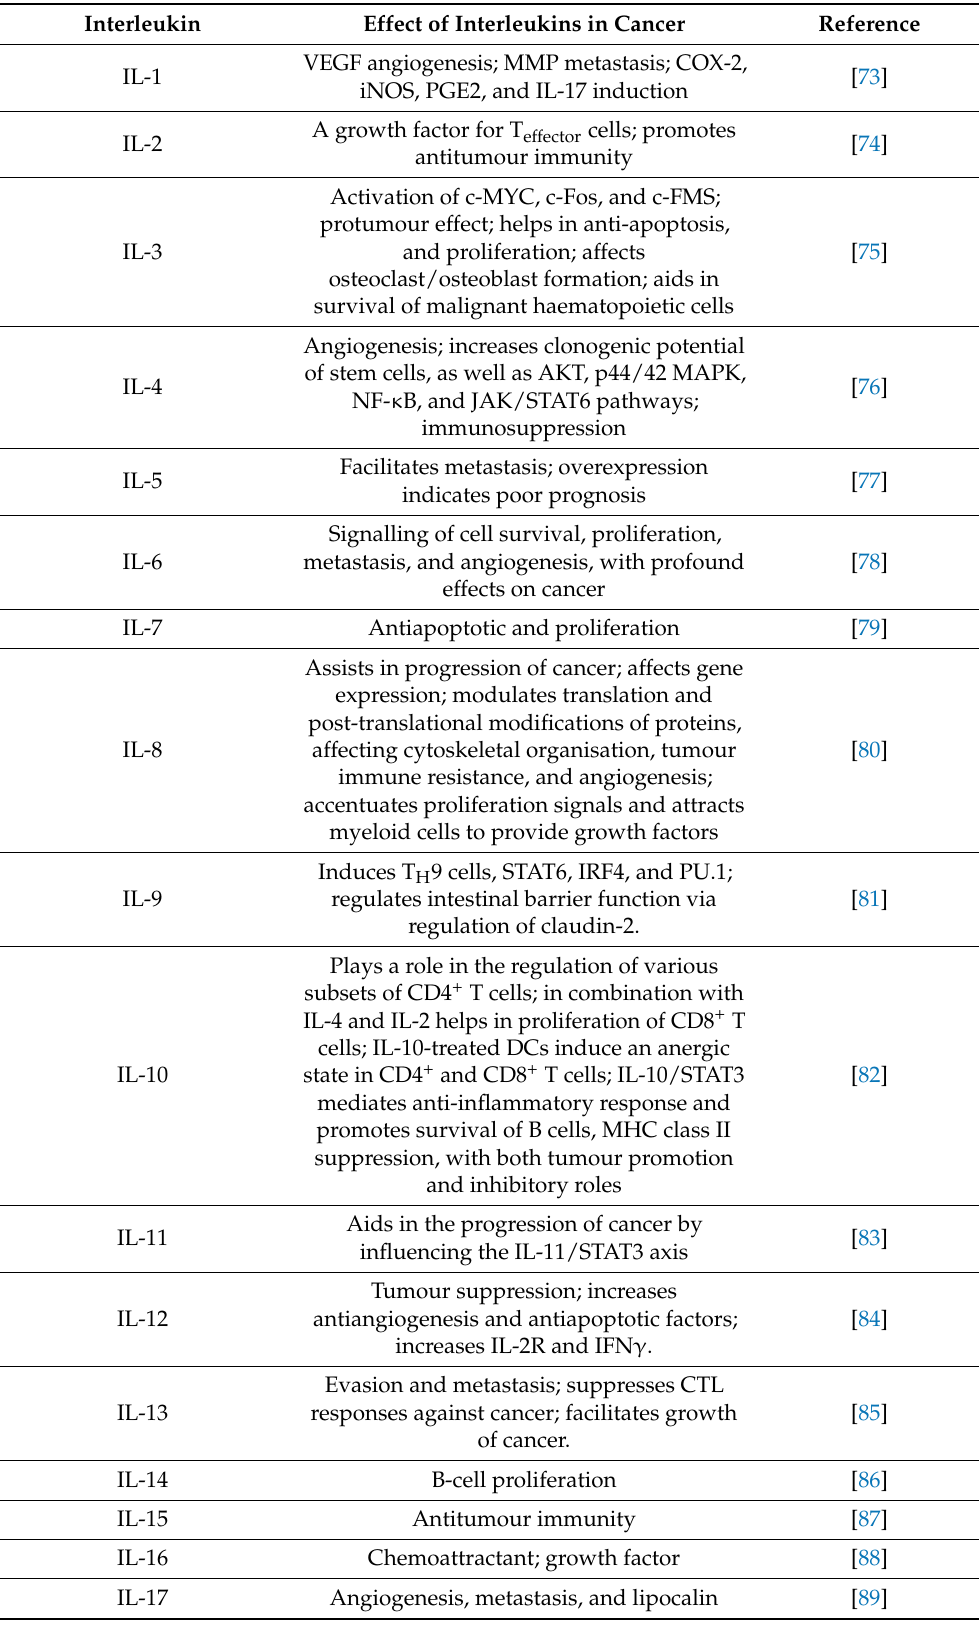
Table 2. Interleukins and